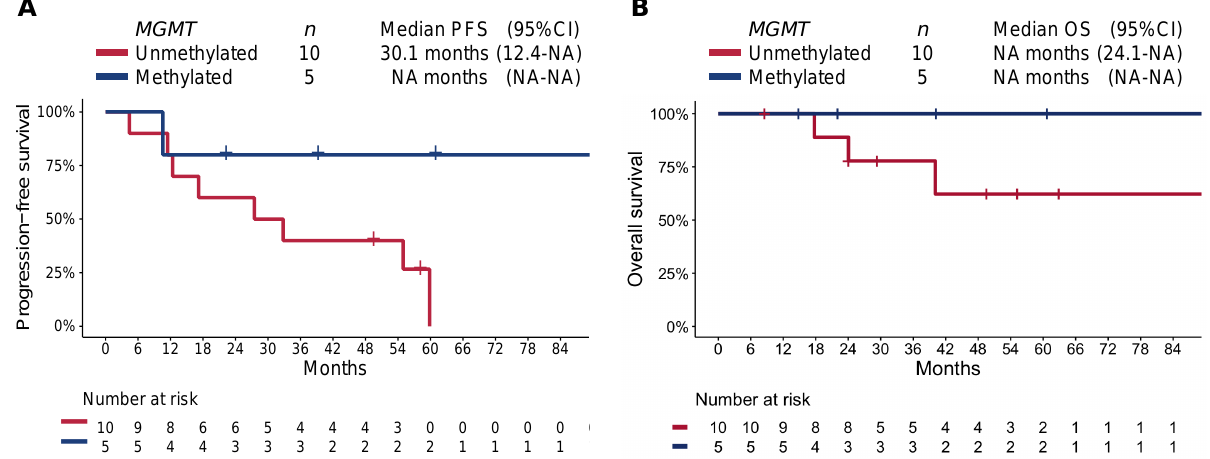
Figure 4. Kaplan–Meier estimate of ( A ) progression-free survival (PFS), and ( B ) overall survival (OS) by MGMT-promoter methylation status in patients with pancreatic